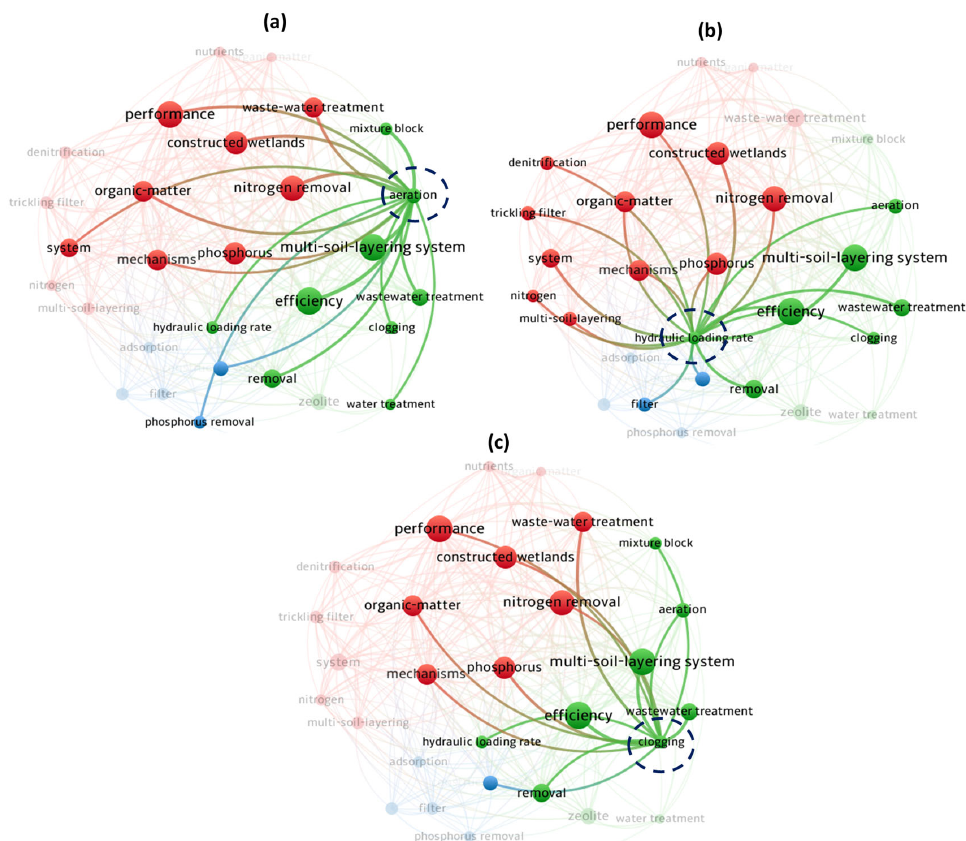
Figure 8. Selections of items in the network map. ( a ) Aeration, ( b ) HLR, ( c ) clogging. The distance between two items reflects the strength of the association, while the lines show the relationships between the items. Each color indicates a cluster that groups the more related terms; aeration, HLR, and clogging belong to the same cluster. To avoid overlapping labels, some extracted items are not presented on the network